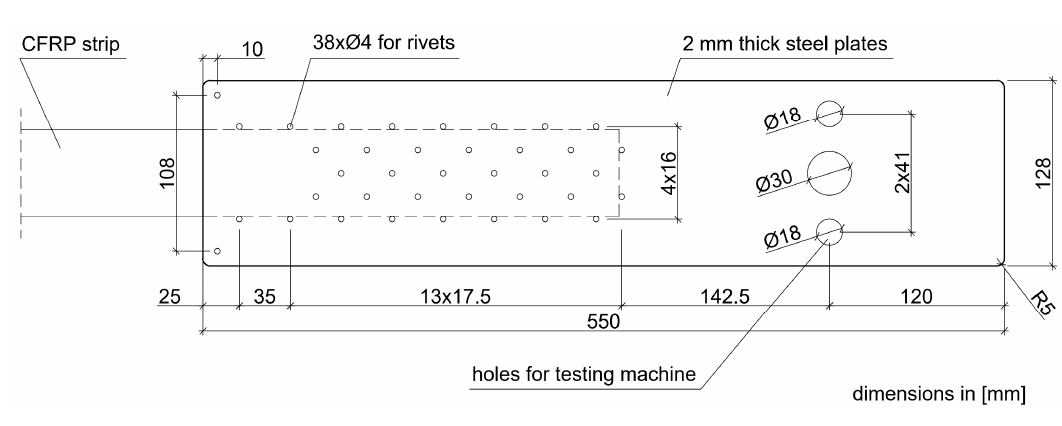
Figure 2. Arrangement of the rivets, S1N–S2N, series’ specimens (NPS I).